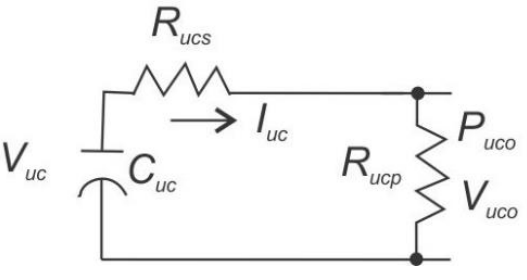
Figure 6. UC electrical model.